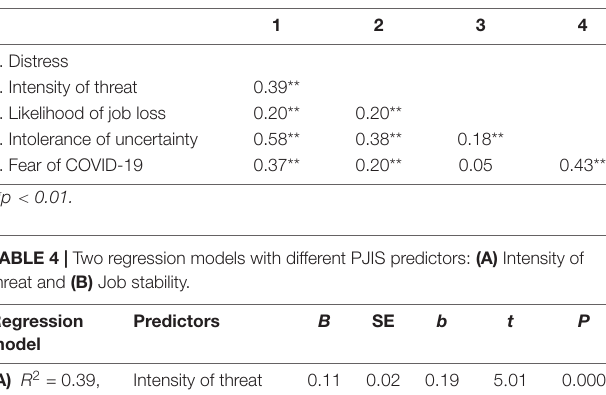
TABLE 3 | Intercorrelations of all variables used in research.